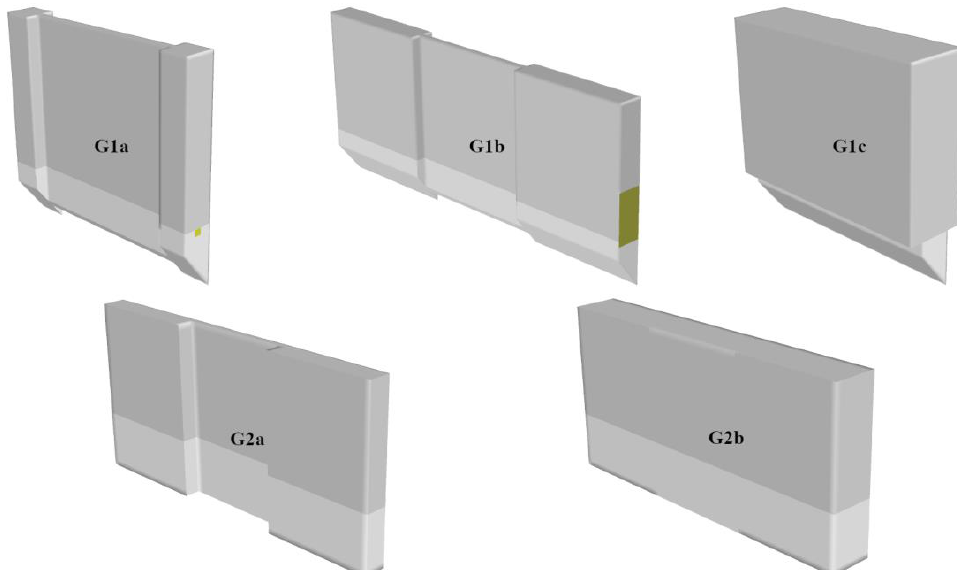
Figure 4. Variants of the MLL geometry G1 and G2. Geometries G1a, G1b and G2a are considered for WC/SiC MLL (optimum thickness of 4.5 µ m) at 8 keV, while the lens thickness of G1c and G2b is 45 µ m, optimized for B 4 C/SiC at 8